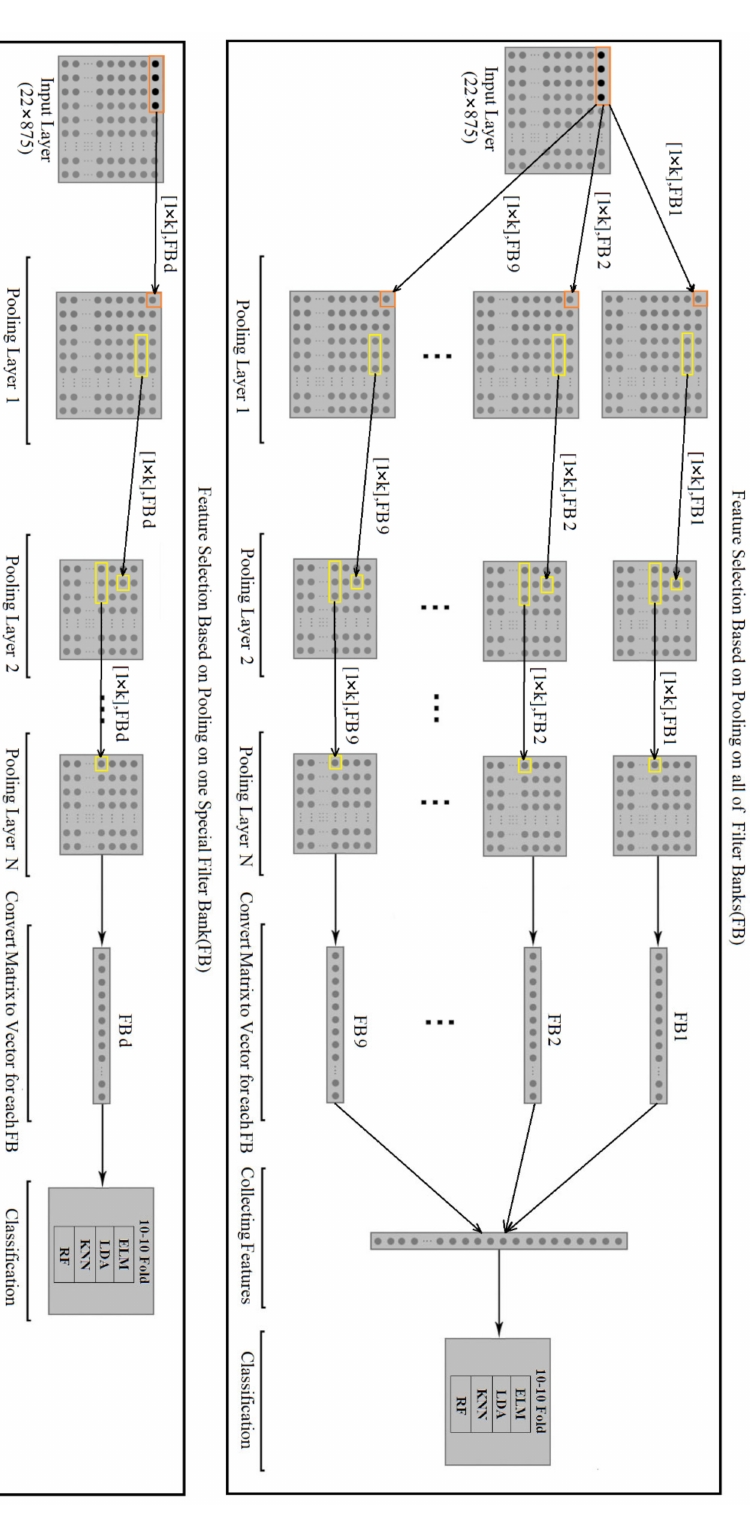
Figure 6. Reduction of channel dimensions based on the deep learning sampling model on a single filter bank or the entire filter